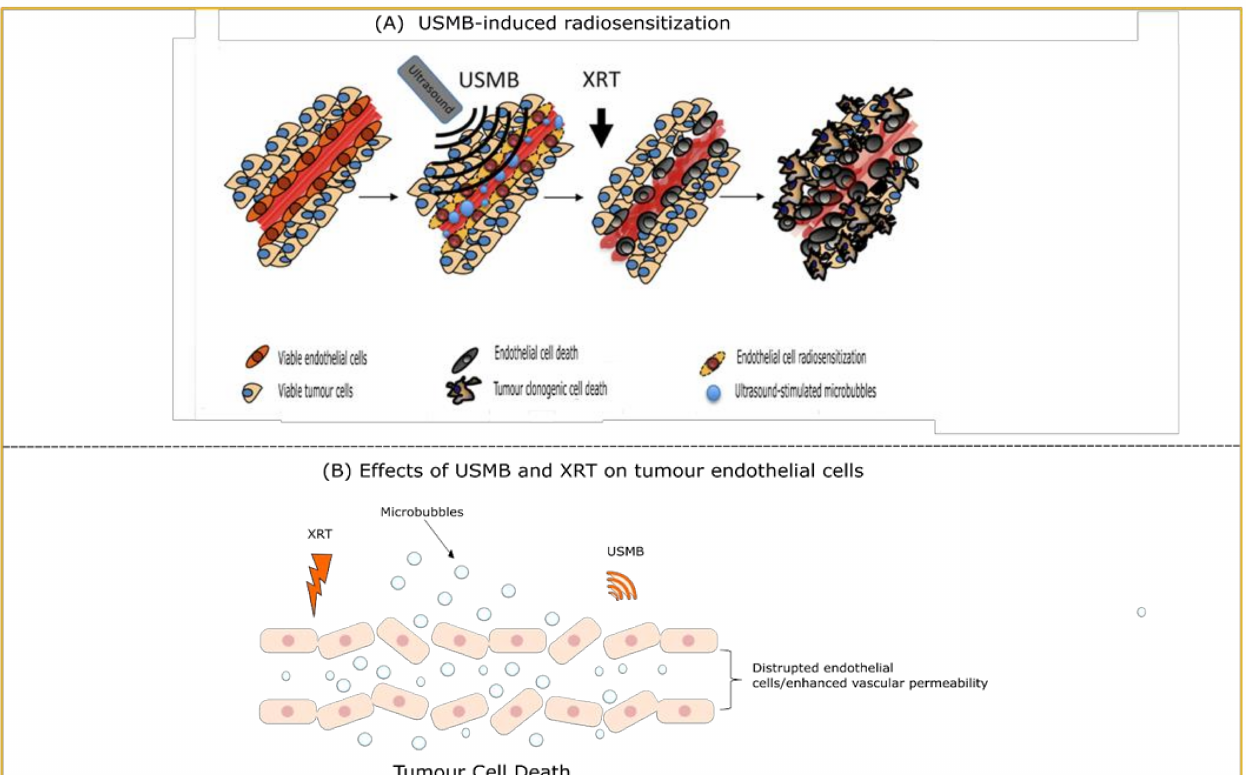
Figure 2. ( A ) Diagram illustrating the effect of USMB and XRT on tumour endothelial cells. Pre- treatment of tumour cells with USMB radiosensitizes the cells. Exposing cells with XRT then cause endothelial cell damage followed by extensive tumour vasculature deterioration. This ultimately leads to tumour cell death. Administration of angiogenesis inhibitor can abrogate the entire process making tumour cells radioresistant. Adapted with permission from [73]. ( B ) USMB treatment results in endothelial cell membrane perturbation resulting in increased vascular permeability. The process of cavitation causes bubbles oscillation, contraction, and expansion finally causing it to collapse into tiny bubbles. This results in bioeffects of endothelial cells and nearby surrounding tissues. The treatment of USMB followed by XRT induces an enhanced tumour cell death/tumour response. Abbreviations: XRT = radiotherapy; USMB = ultrasound-stimulated